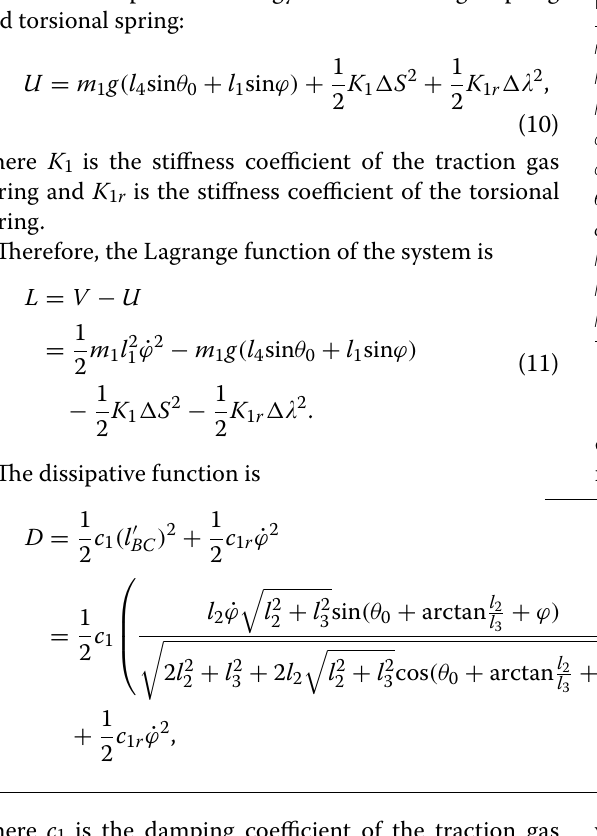
Table 1 Design parameters of the first-stage buffer system Parameter